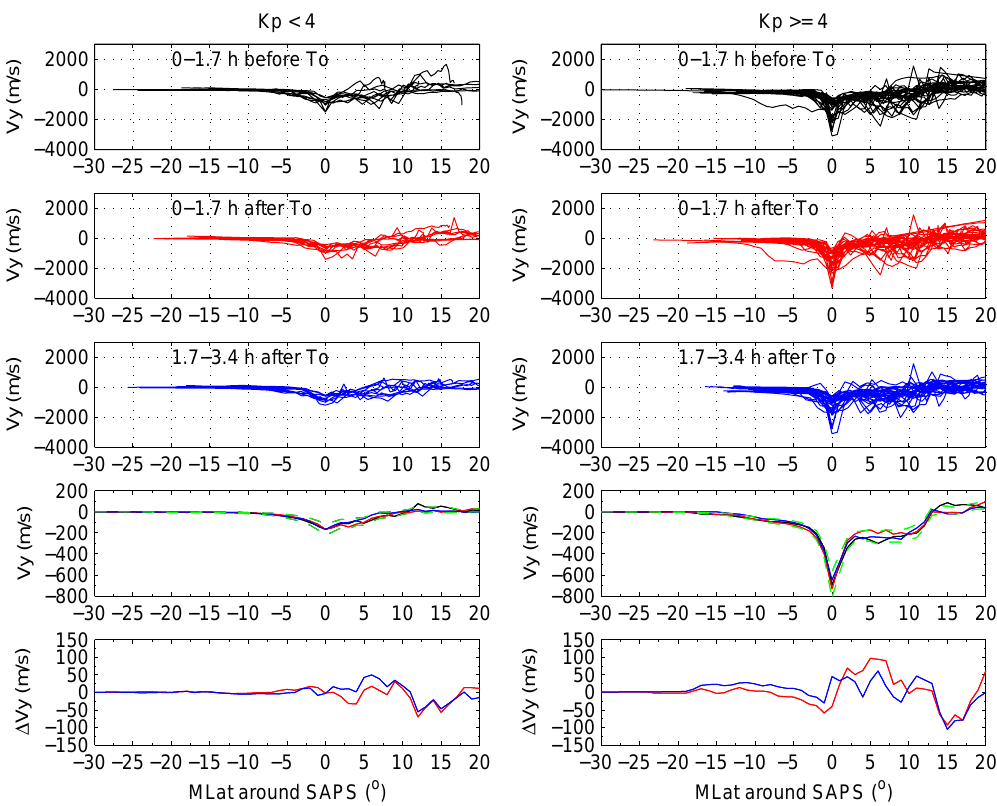
Fig. 10. Stack plots and superposed epoch analysis of the cross track velocity observed by DMSP for Kp < 4 and Kp ≥ 4 (top four). The key MLat of “0” denotes MLat where SAID peak occurs. Positive denotes eastward velocity. Black lines mark orbits before onset, T0. Red and blue lines denote the successive two orbits after T0. Green dashed lines are mean value of uncertainty for all three curves. Bottom shows the residual velocity after subtraction of the successive two orbits after T0 from the reference